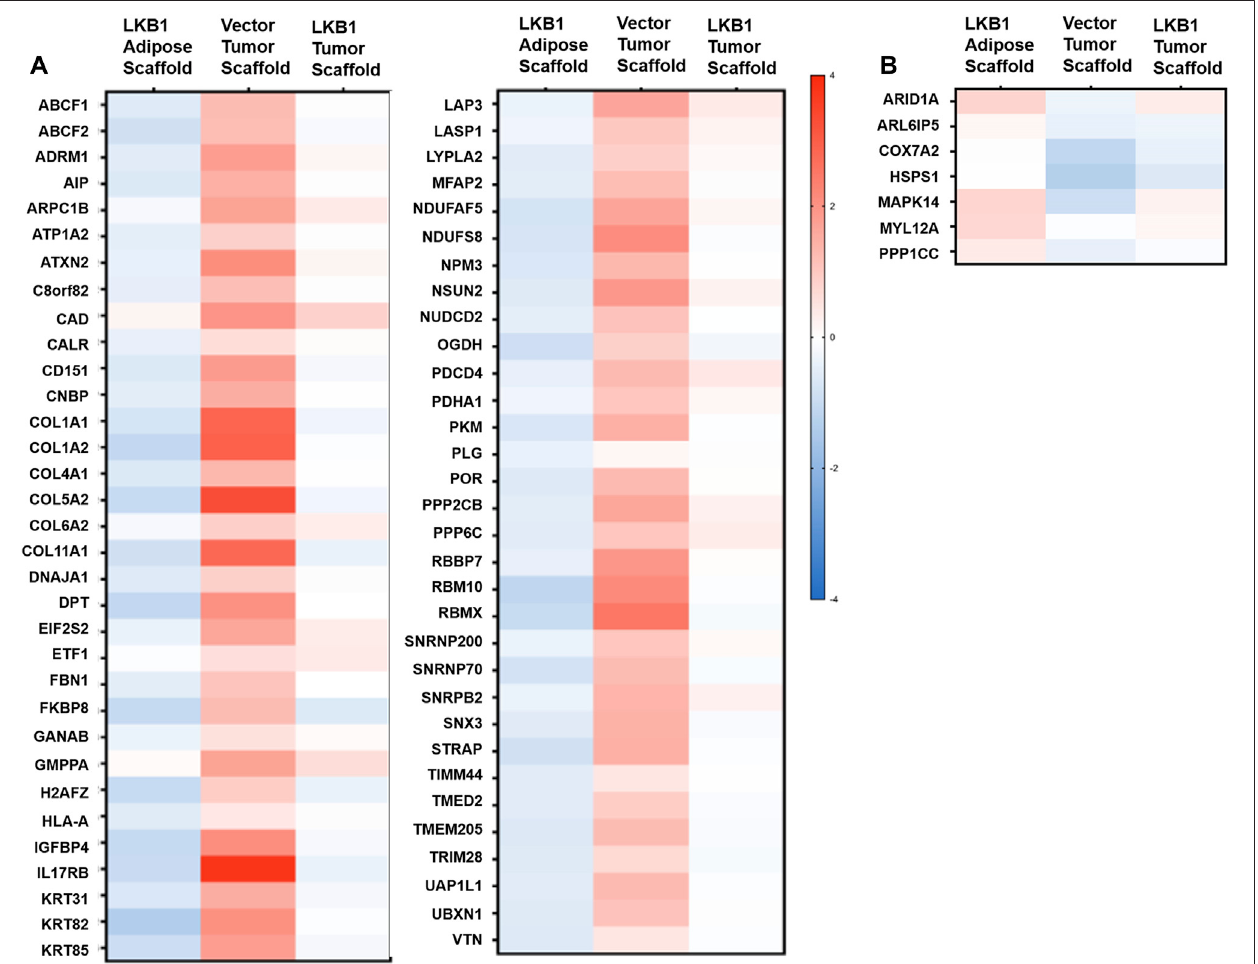
FIGURE 4 | LKB1 overexpression in MDA-MB-231 cells inhibits pro-adipogenic signals in the TME. MDA-MB-231 and LKB1 cells were seeded on tumor and adipose scaffolds and implanted in the M.F.Ps of SCID/beige mice. At necropsy, tumors were removed, decellularized, and evaluated for differences in protein expression through proteomics. Normalization was carried out on MDA-MB-231 cells seeded on the adipose scaffold. Results represent relative fold change in protein expression for all detected proteins that demonstrated an (A) increase in the expression in MDA-MB-231 cells seeded on tumor scaffold and repression in protein expression in MDA-MB-231-LKB1 cells seeded on the tumor scaffold or a (B) decrease in expression in MDA-MB-231 cells seeded on the tumor scaffold and an increase in protein expression in MDA-MB-231-LBK1 cells seeded on the tumor scaffold. Fold changes in all groups were compared to those in MDA-MB-231 cells seeded on the adipose scaffold. N = 3 mice per group for all groups. Blue bands = decreased protein expression and red bands = increased protein